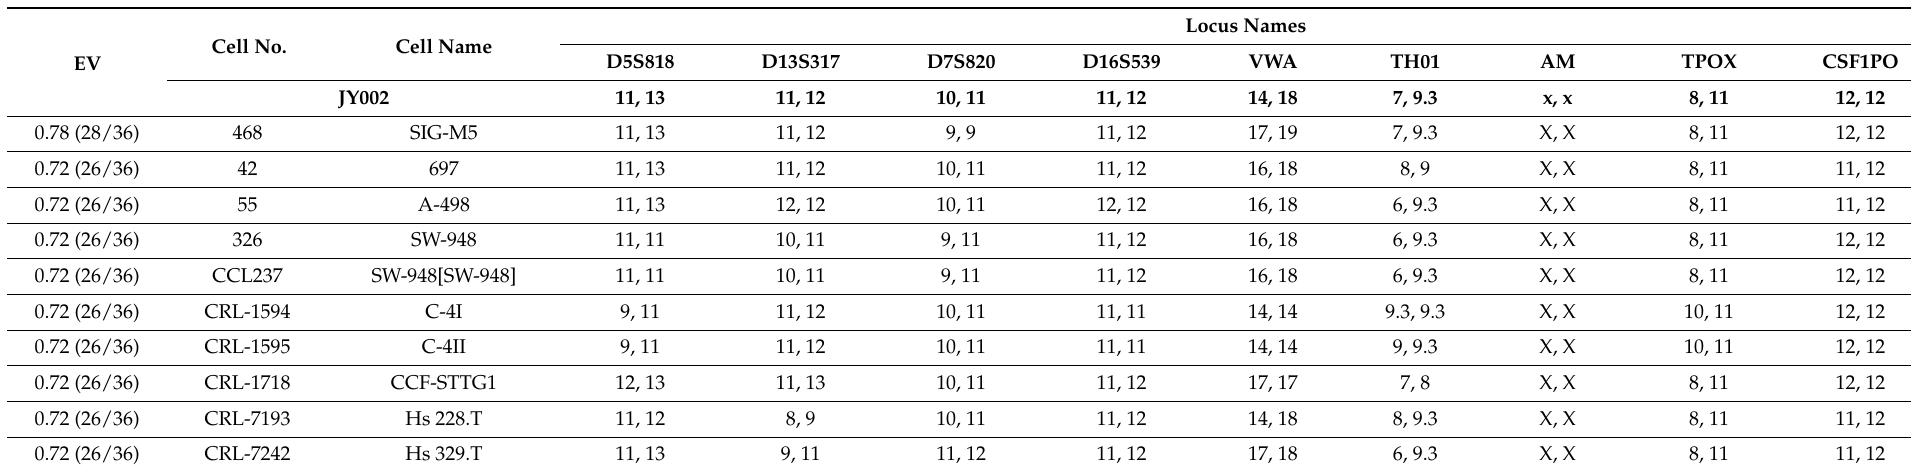
Table 2. Short tandem repeat profiling of